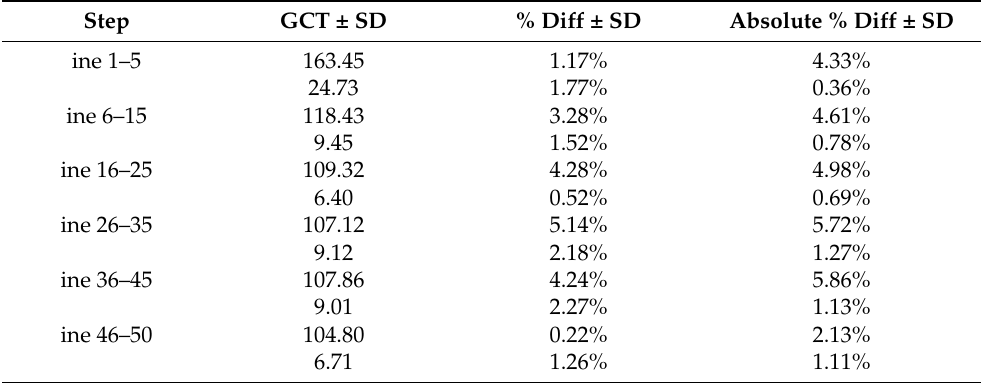
Table 1. Mean IMU measured ground contact time (GCT), and its relative and absolute percentage deviation to the reference system for various step ranges of all 100-m sprints. The first and last intervals are summarized into five steps. All other intervals combine ten steps. The last five steps showed the lowest percentage difference.